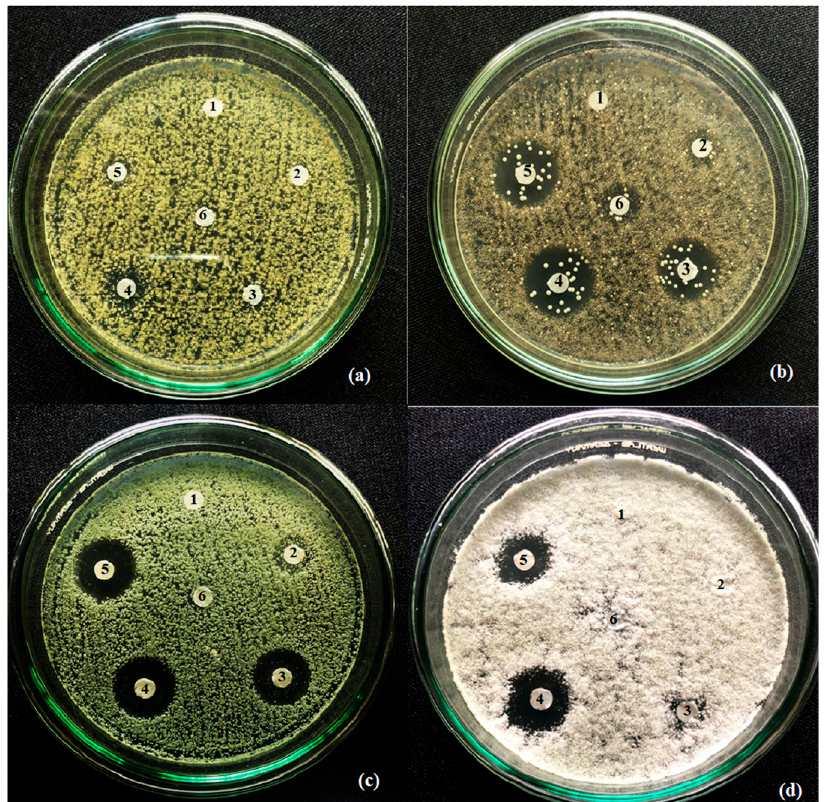
Figure 7. Antifungal susceptibility testing against ( a ) Aspergillus flavus NBRC 33021; ( b ) Aspergillus niger NBRC 4066; ( c ) Aspergillus clavatus NBRC 33020; ( d ) Fusarium solani NBRC 31094; ( 1 ): Negative control—DMSO 5%; ( 2 ): WRE 25 mg/mL; ( 3 ): WRE 50 mg/mL; ( 4 ): WRE concentrate 75 mg/mL; ( 5 ): WRE 100 mg/mL; ( 6 ): Positive control—natamycin 0.2 mg/mL.